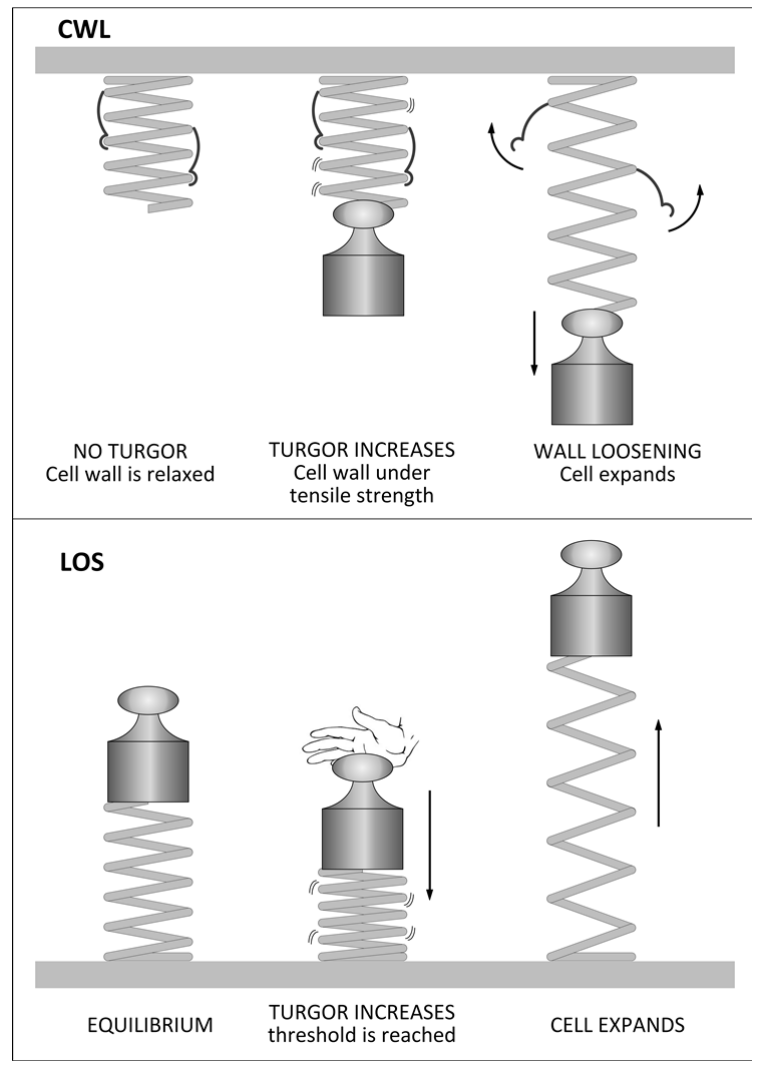
Figure 1. Schematic representation of the two principles (turgor pressure and wall tensile stress) regulating plant cell growth. The top part of the figure illustrates the CWL (Chemical Wall Loosening) mechanism by using a spring, hooks and a weight, while the lower part schematizes the LOS model. In the CWL model, the spring (which represents the cell wall), under the action of the weight (the internal turgor pressure), is in tensile stress and the potential energy of the system increases; when the transducer (wall loosening enzymes) releases the weight by unfastening the hooks holding the spring (which represent the inter/intra-chain bonds of wall polysaccharides), the energy accumulated is transformed into kinetic energy (growth). Therefore, the action of wall loosening enzymes is required for growth, according to the CWL model. According to the LOS model, the compression of the spring ( i.e. , the cell wall) by an increase in turgor pressure (here represented as a hand pushing the weight), proceeds until a threshold is reached (wall yield threshold). Beyond this threshold, the wall yields and expansion occurs. Therefore, according to the LOS model, growth depends on the intrinsic properties of the